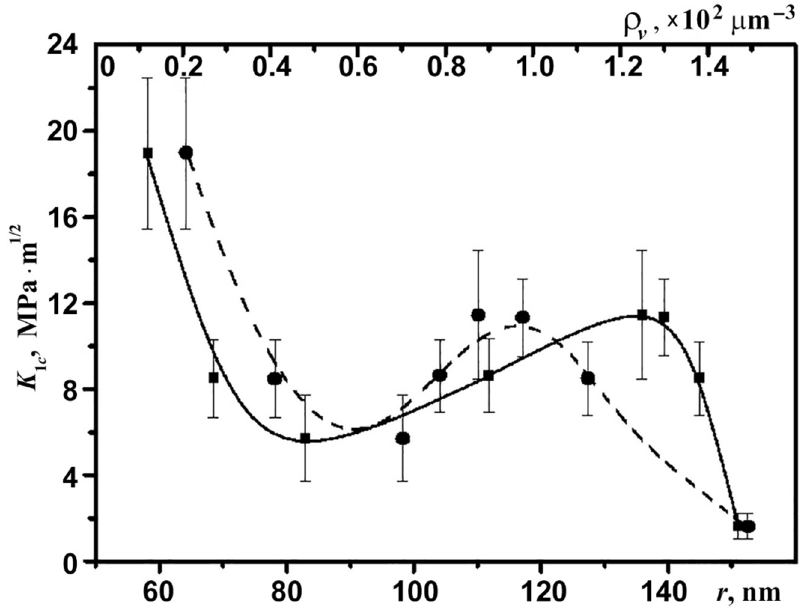
Figure 11. Crack resistance of the Fe 58 Ni 25 B 17 AA as a function of the size of crystalline particles r (dashed line) and their volume density ρ V (solid line). (dashed line) and their volume density ρ V (solid